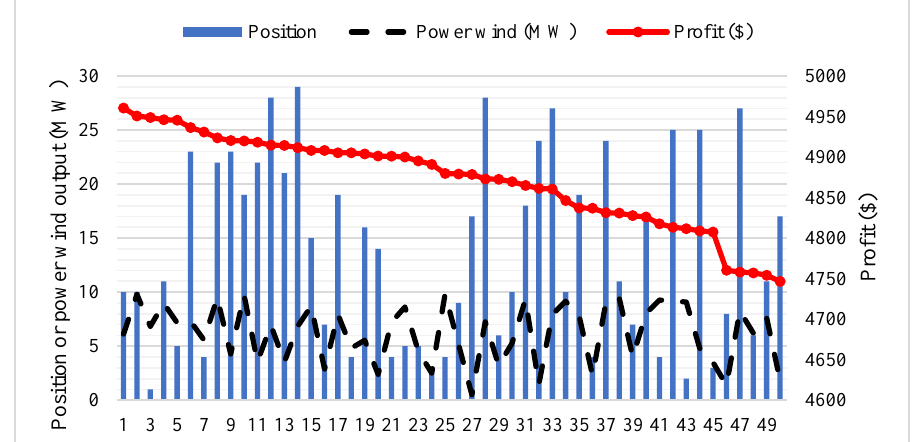
Figure 15. Optimal location and size of wind turbine obtained by SSA for 50 runs.